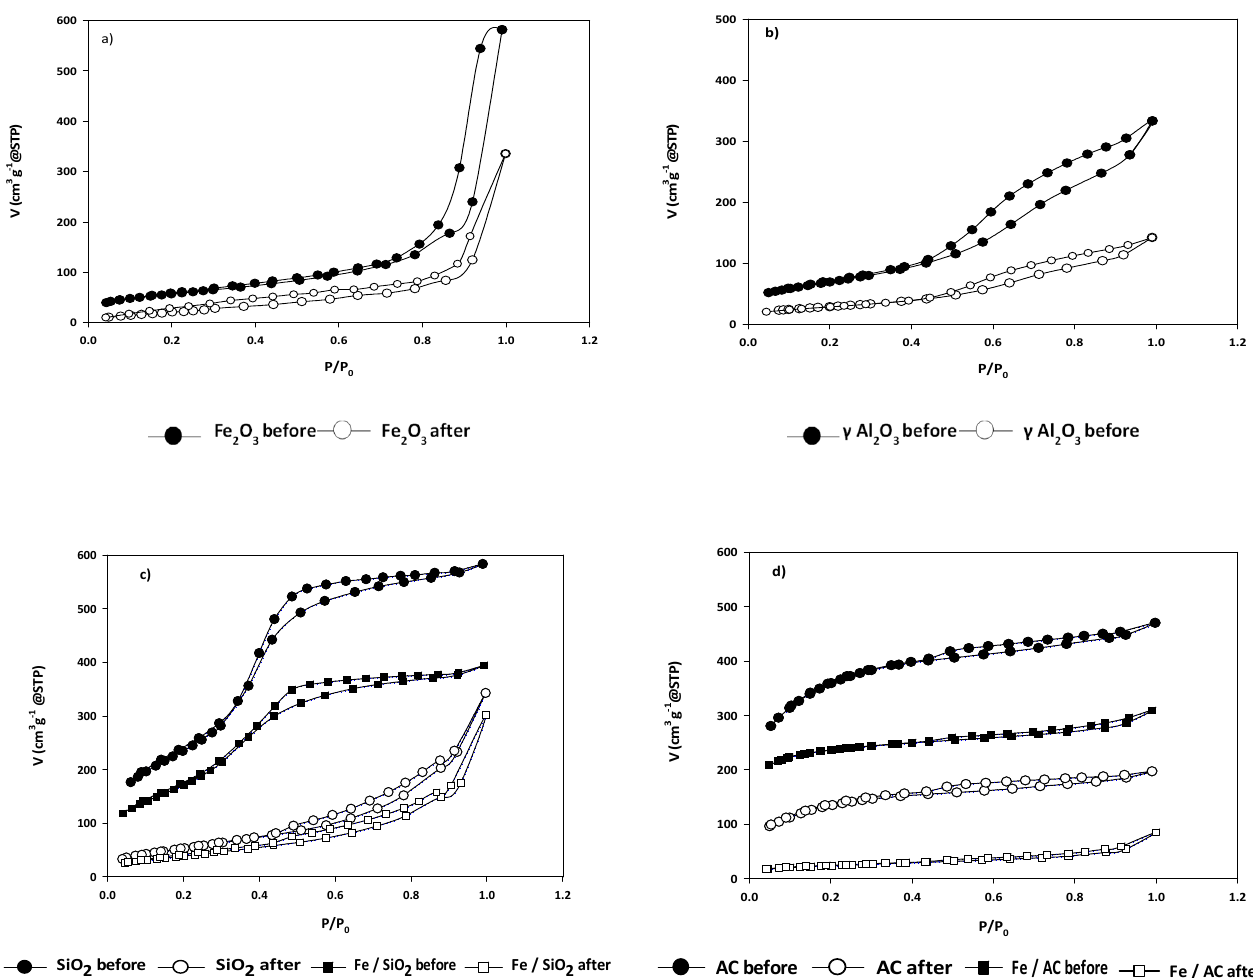
Figure 1. N 2 adsorption–desorption isotherms for support before and after the batch dark fermentation: ( a ) Fe 2 O 3 ; ( b ) γ -Al 2 O 3 ; ( c ) SiO 2 and Fe/SiO 2 ; ( d ) AC and Fe/AC.